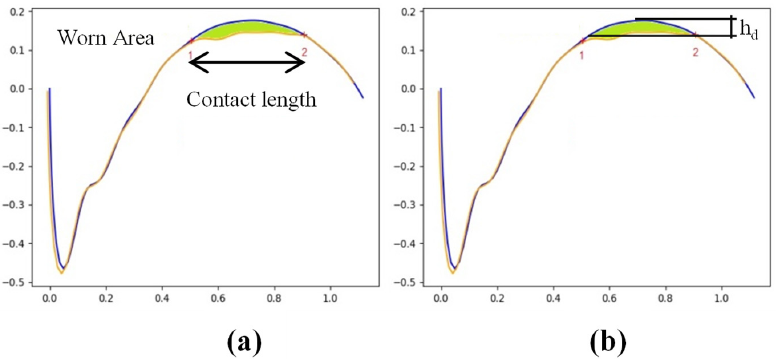
Figure 7. ( a ) Contact area and zone of the dresser where wear concentrates; ( b ) definition of wear height h d .